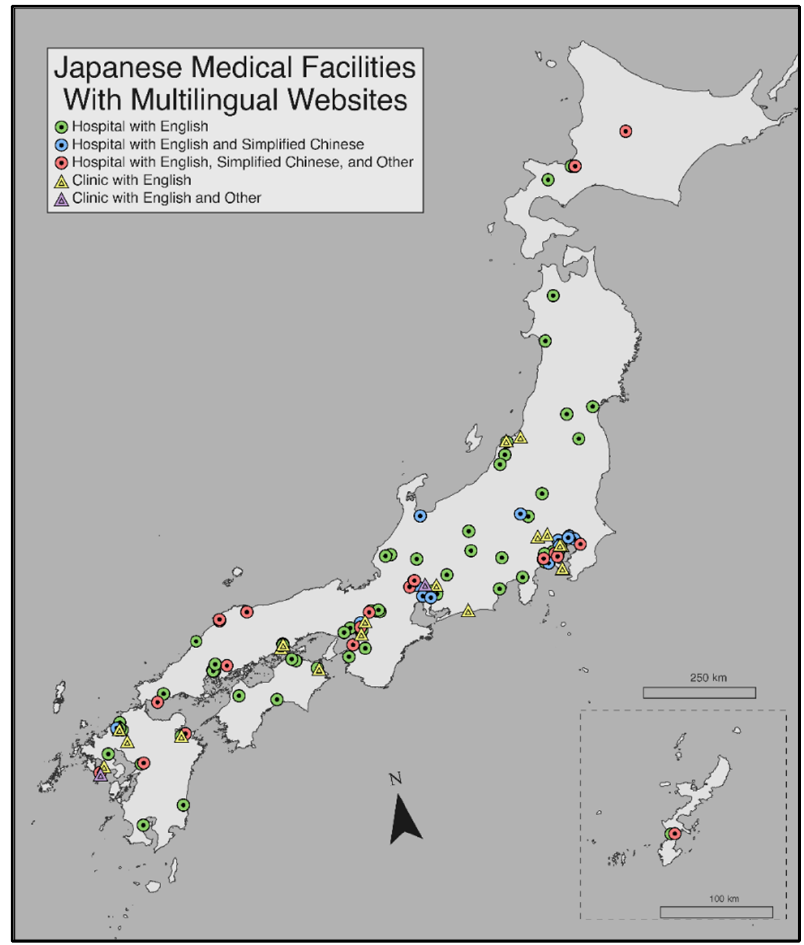
Figure 2. Map of health care facilities with multilingual webpages ( n = 123) according to the real- world search results.